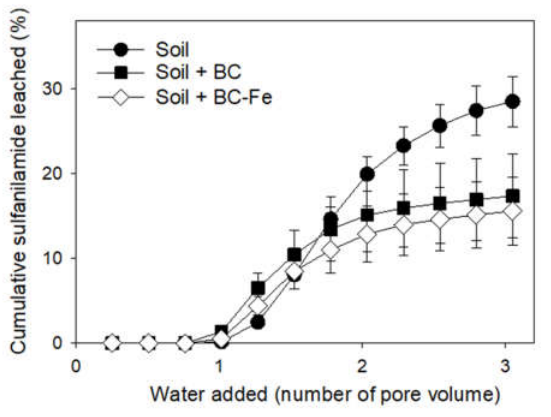
Figure 5. Cumulative sulfanilamide breakthrough curves in soil and soil treated with BC and BC-Fe. Table 4. Summary of leaching data extracted from the relative and cumulative breakthrough curves (BTCs) of SFA in untreated soil and soil treated with BC and BC-Fe. Different letters in each column indicate significant differences in values ( p <